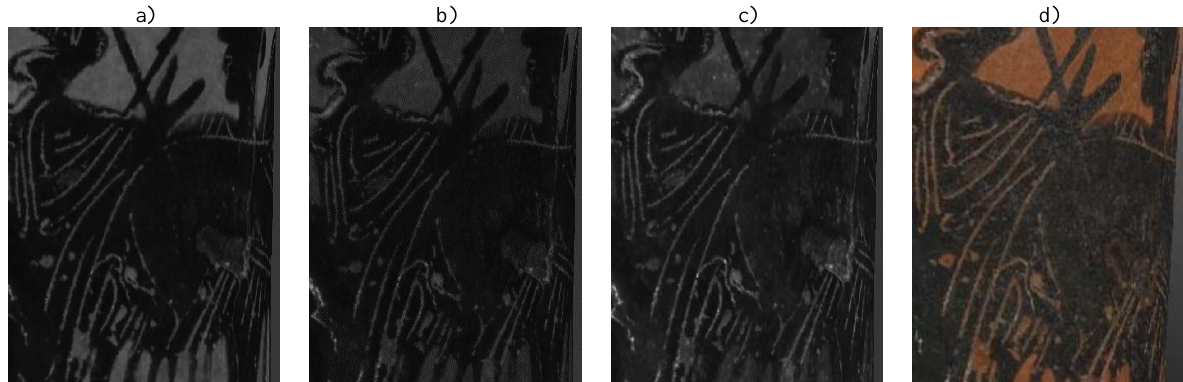
Figure 2. Detailed view of the mesh model from the 3D scanner coloured with the three separate channels R (a), G (b) and B (c), and of the photogrammetric dense point cloud with RGB information (d).